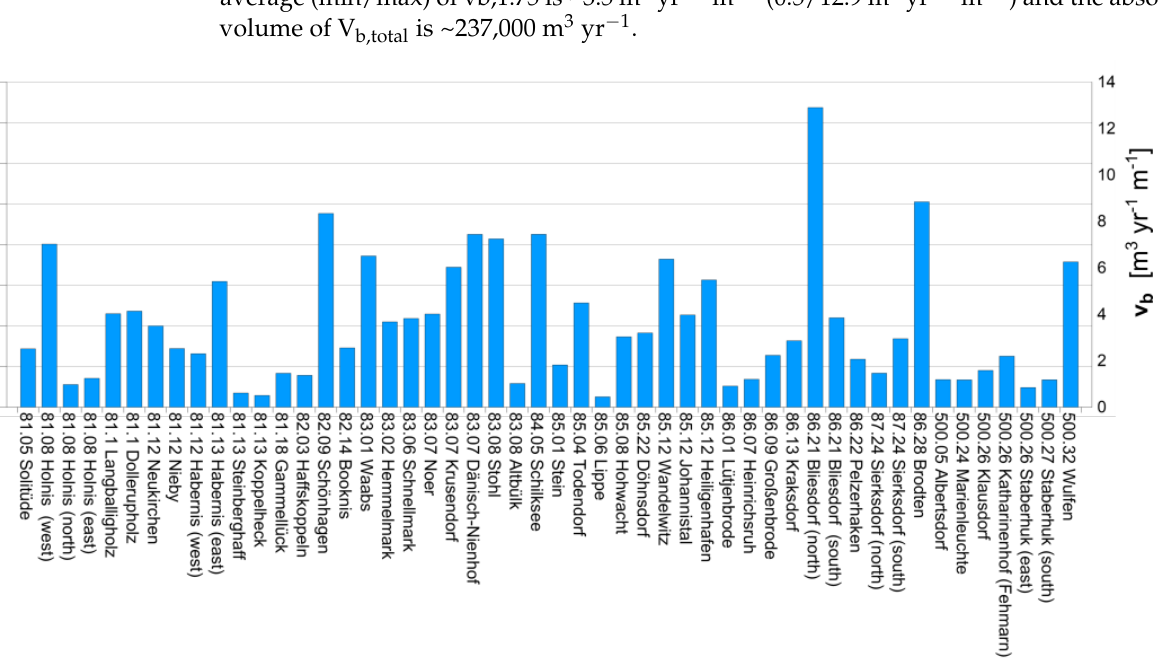
Figure 3. Specific eroded volumes v e ( left axis) and specific bulk volumes v b (bulk factor h 1.75 ) ( right axis) of the observed 50 cliff sites, based on [36].